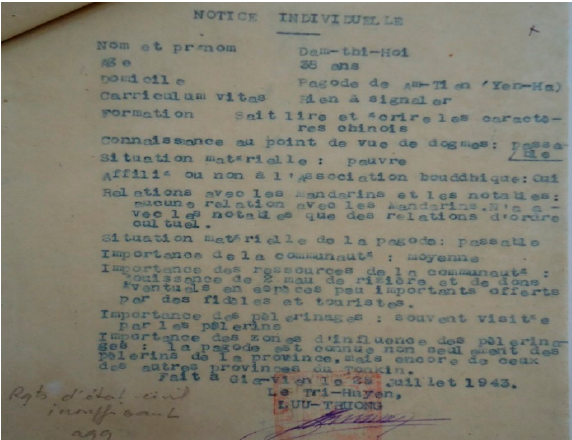
Figure 1. The instruction concerning individual nun Dam Thi Hoi (dossier